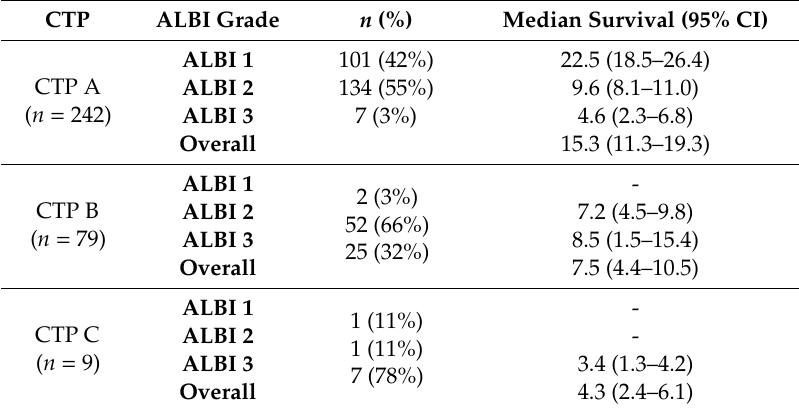
Table 3. The distribution of ALBI Grade in each CTP